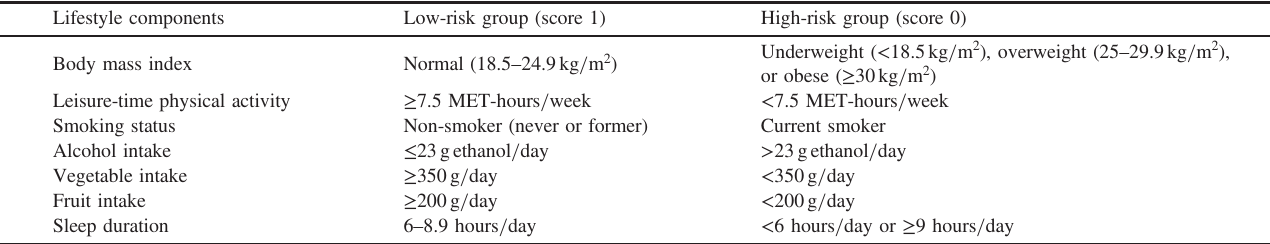
Table 1. Components of the Healthy Lifestyle Index